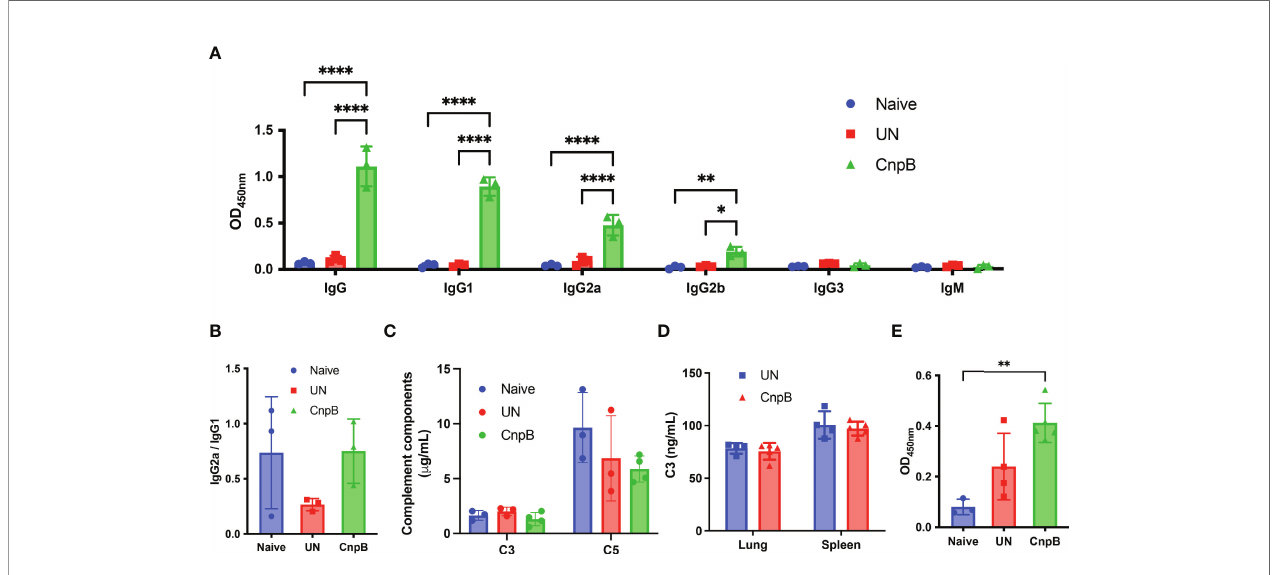
FIGURE 5 | Antibody and complement detection of CnpB-immunized mice after M. tuberculosis intranasal infection. After M. tuberculosis H37Ra intranasal challenge for 8 weeks, antibodies and complements were detected. (A) Sera of CnpB immunized (CnpB) mice and unimmunized (UN) mice were collected for antibodies detection using ELISA ( n =3). The collection time points was 8 weeks after infection. (B) The ratio of IgG2a/IgG1 in panel A was calculated ( n =3). (C, D) The levels of complement C3/C5 in sera ( n = 3) (C) and complement C3 in lung/spleen homogenate ( n = 4) (D) were assayed by ELISA. (E) The levels of sIgA in BALF were assayed by ELISA. The results are shown as mean ± SD. * P < 0.05, ** P < 0.01, **** P <